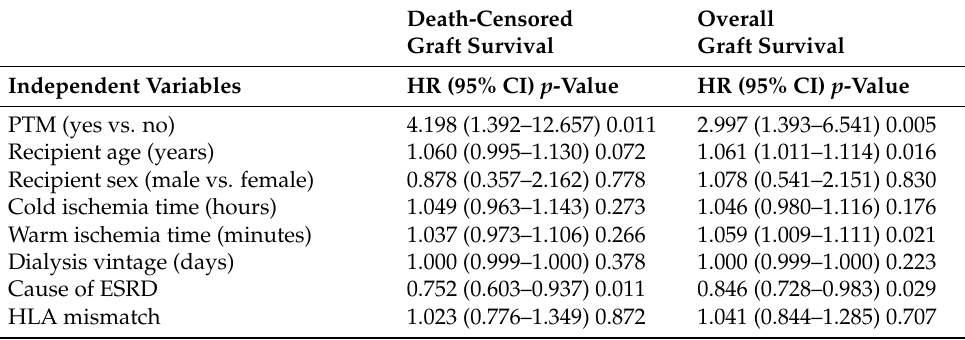
Table 5. Cox proportional hazards regression model with logistic regression analysis of five-year death censored and overall graft survival.